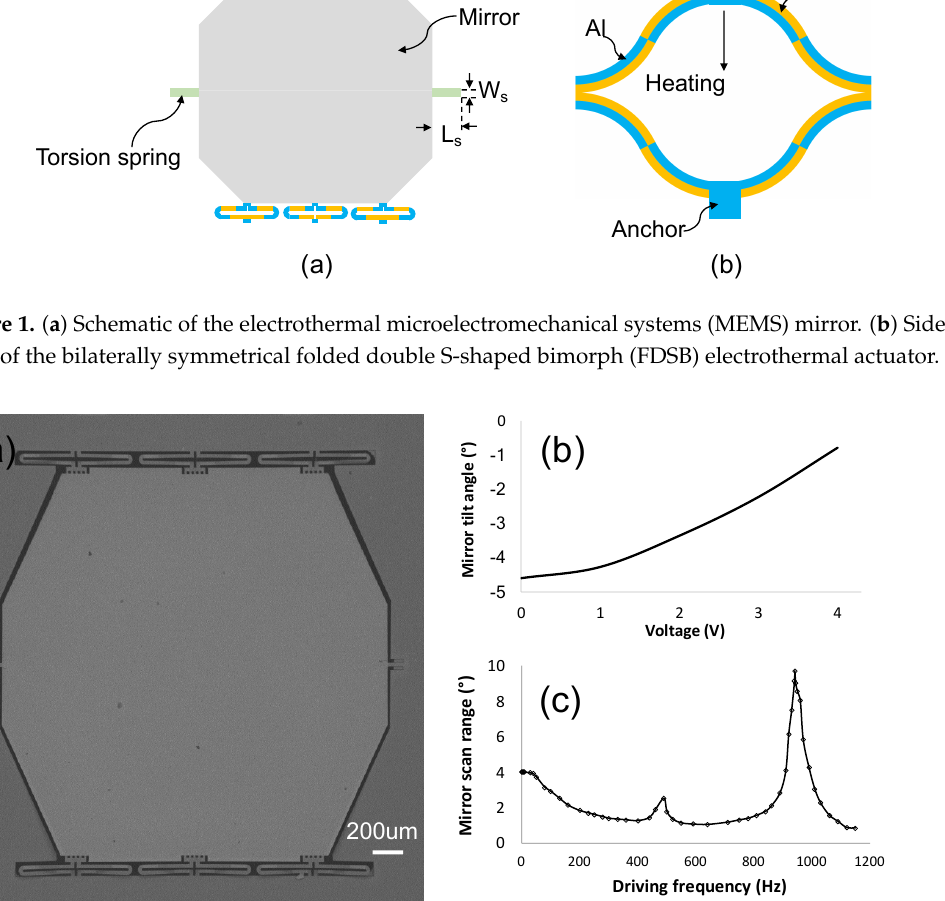
Figure 2. ( a ) Scanning electron microscope (SEM) image of the MEMS mirror. ( b ) Quasi-static angle of the MEMS mirror vs. voltage response. ( c ) Frequency response of the MEMS